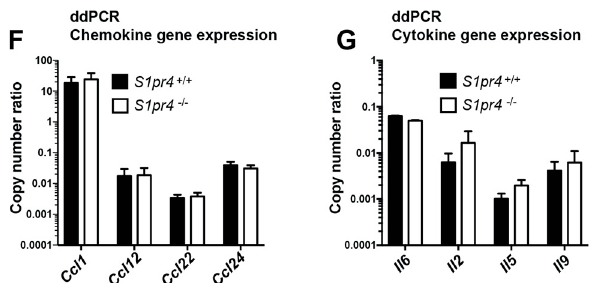
Figure 2. Analysis of degranulation, cytokine and chemokine responses in primary S1P 4 -deficient mast cells. ( A – C ) Degranulation response to antigen stimulation ( A , B ) or to pharmacological stimulation with thapsigargin ( B ). Mast cells from S1pr4 +/+ (solid) and S1pr4 − / − mice (open) were grown in the presence of stem cell factor (SCF) and recombinant mIL-3 for 6–7 weeks (BMMC) or 14 days (PDMC) and sensitized with 100 ng/mL anti-dinitrophenyl (DNP)-IgE in cytokine-free media for 14 h. Degranulation was assessed by measuring the release of β -hexosaminidase into the media after 30 min of stimulation with the indicated concentrations of DNP (antigen; Ag) ( A ), 1 µM thapsigargin ( B ), or antigen in addition to 1 ng/mL recombinant IL-33 ( C ). Data represent the mean ± SE of results pooled from 4–8 independent cultures. ( D , E ) BMMC from S1pr4 +/+ (solid bars) and S1pr4 − / − mice (open bars) were sensitized overnight with 100 ng/mL anti-DNP IgE in cytokine-free media. Cells were washed, stimulated with the indicated concentrations of Ag and the amounts of IL-6 ( D ) and TNF- α ( E ) secreted into the media measured by ELISA at 4 h post-stimulation. The limit of detection for IL-6 and TNF- α quantitation by ELISA are shown by a dotted line in panels C and D at 0.0018 ng/mL and 0.00721 ng/mL, respectively. Data is pooled from 4 independent cultures. ( F , G ) Validation by ddPCR of the normalized relative expression of select chemokines ( F ) and cytokines ( G ) identified as being variably upregulated in S1pr4 +/+ and S1pr4 − / − BMMC cultures following Ag stimulation. Relative expression of Il6 is included for comparison. Data show mean ± SE of values obtained from at least seven independent cultures of BMMC for each genotype. All comparisons between S1pr4 +/+ and S1pr4 − / − cells were found to be not statistically significant unless otherwise indicated. * p < 0.05.